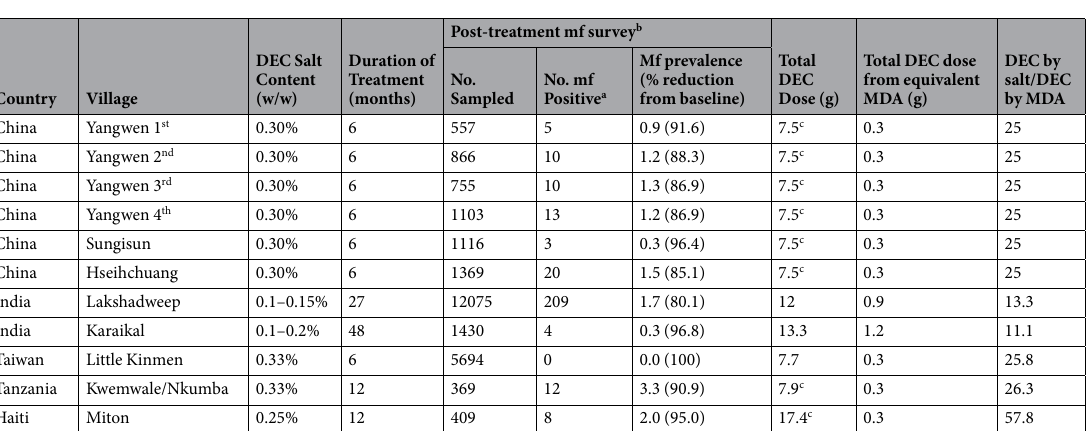
Table 3. DEC-medicated salt community trial details. The ratio DEC by salt/DEC by MDA is a measure describing the total amount of DEC consumed per person by consuming medicated salt relative to the amount of DEC which would be consumed through the standard dose given for annual MDA interventions (6 mg/kg DEC plus 400 mg ALB) over the same time period of the DEC salt treatment. a The number of positive cases is corrected for blood sample volume using a correction factor of 1.15 for 100 μ L and 60 μ L samples and 1.95 for 20 μ L samples30. b Post-treatment mf prevalence observations were made at the end of the community trial